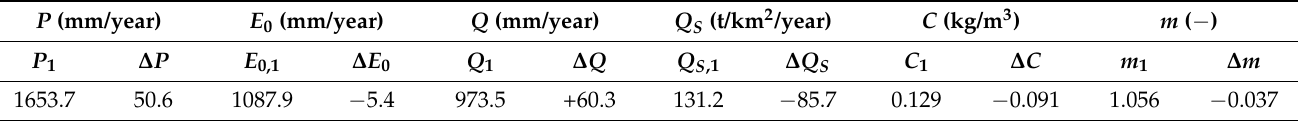
Table 3. Changes of areal annual precipitation ( P ), potential evaporation ( E 0 ), and catchment property ( m ) in the drainage area above Zhuqi, and annual average streamflow discharge ( Q ), average suspended sediment yield ( Q S ), and suspended sediment concentration ( C ) observed at Zhuqi during period-1 (1951–1992) and period-2 (1993–2017).